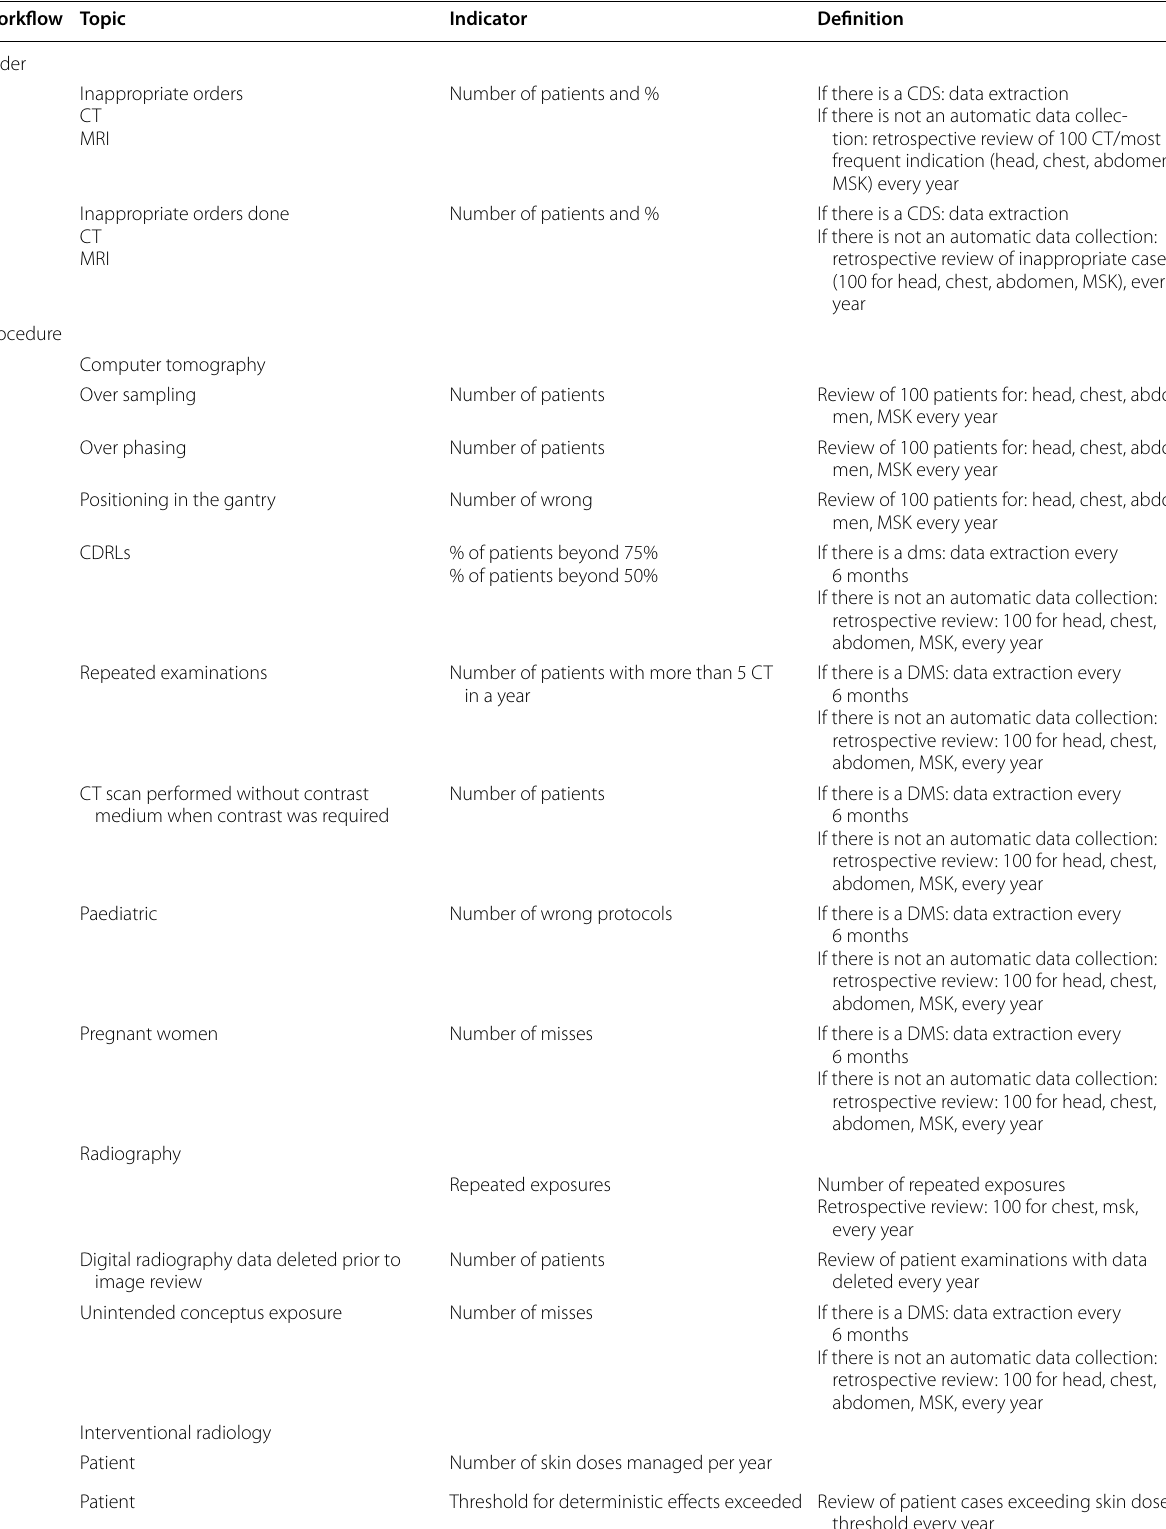
Table 2 Comprehensive overview on radiation protection‑specific KPIs listing topics and indicators for measurements and